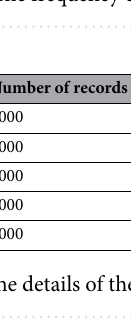
Figure 4. The frequency content of five PCG classes.